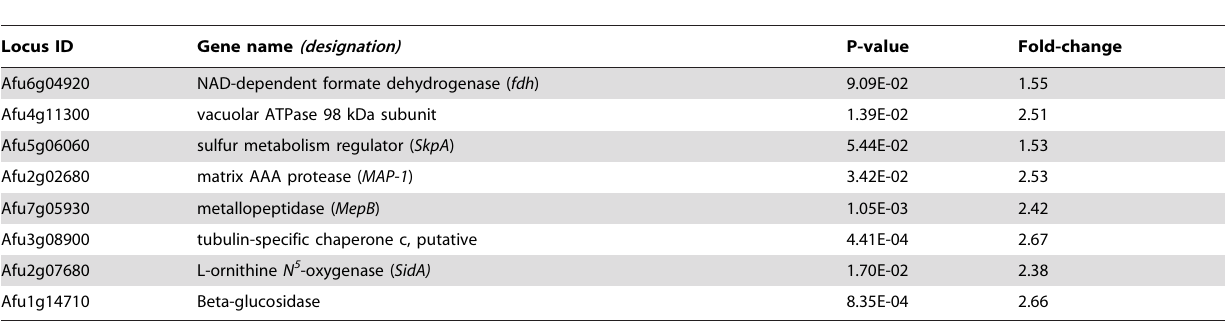
Table 2. Microarray expression data for Aspergillus fumigatus genes chosen for RT-qPCR.